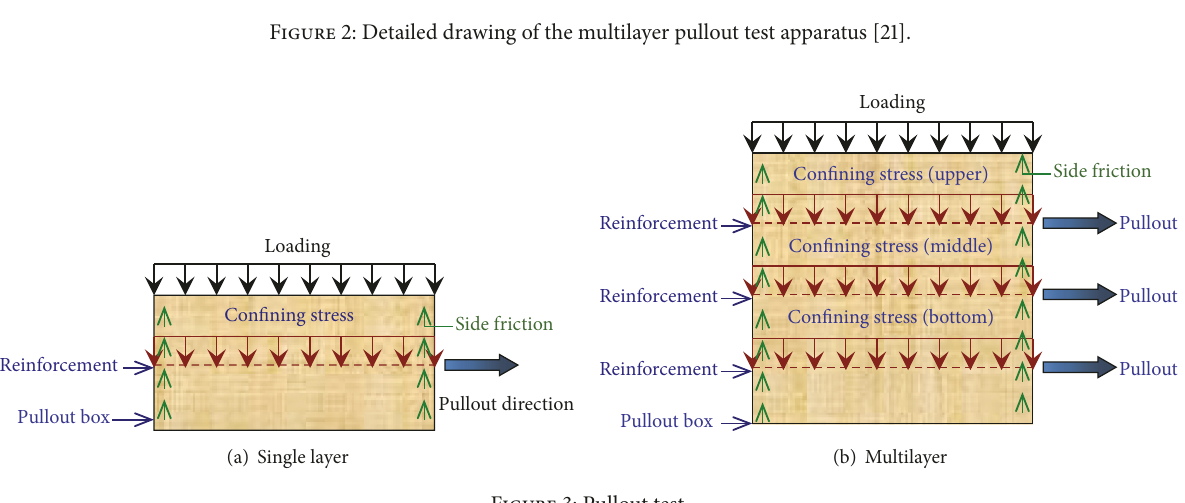
Figure 3: Pullout